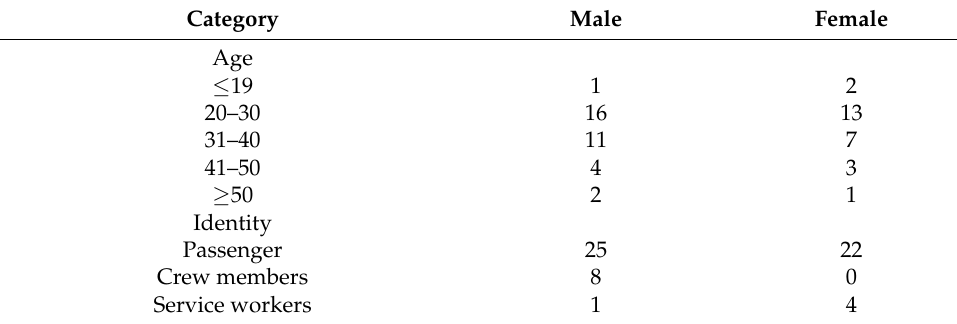
Table 2. Characteristics information of the subjects.